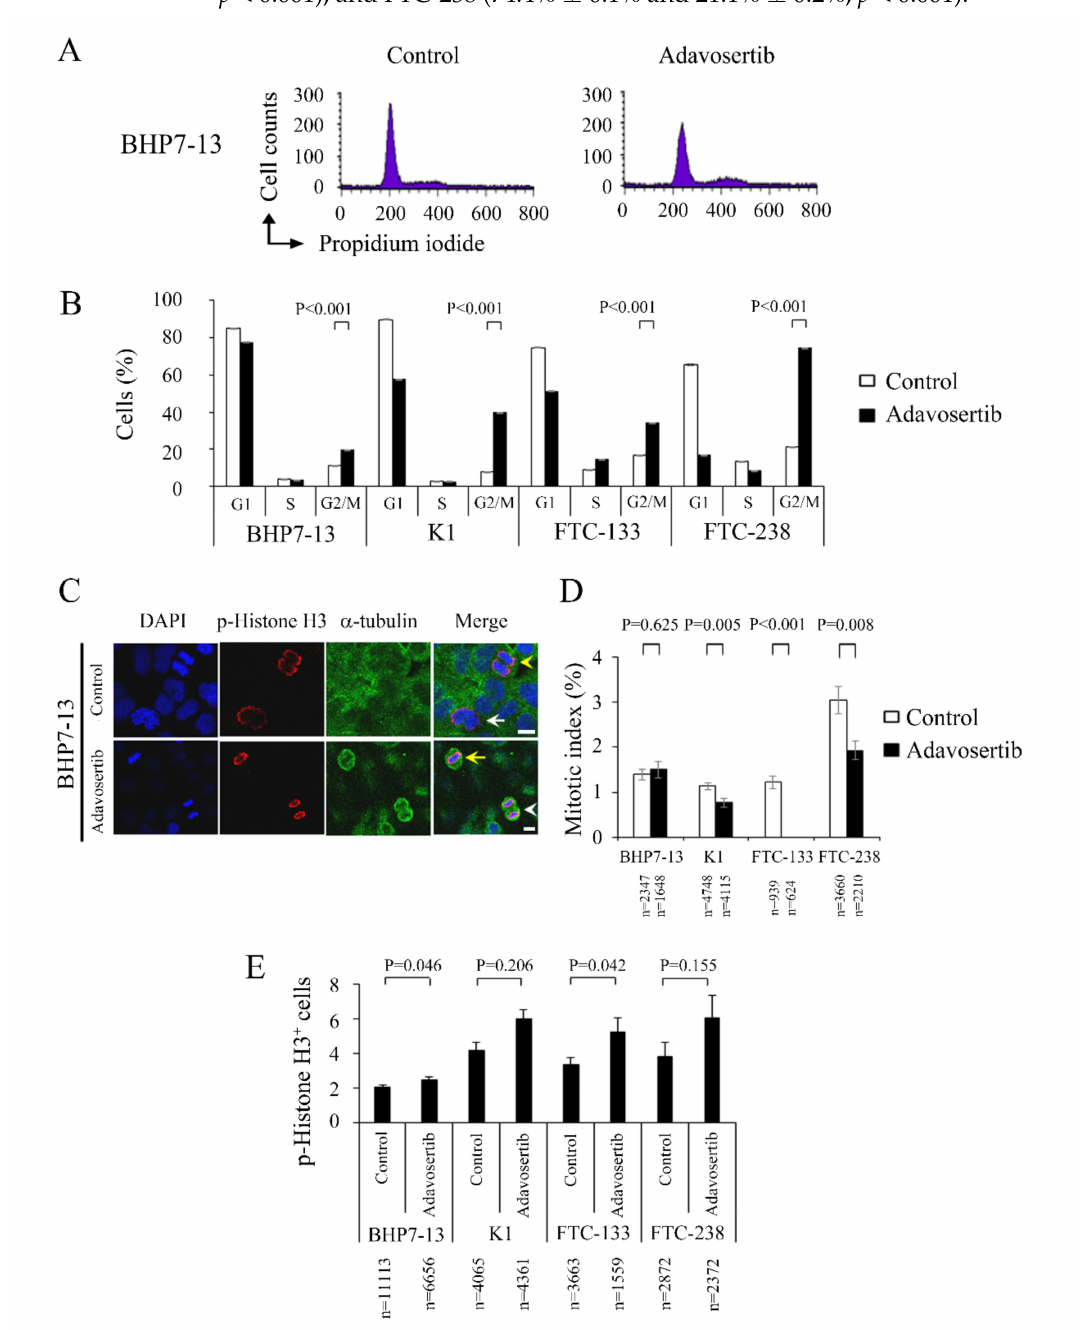
Figure 2. Adavosertib inhibits cell cycle progression in the G2/M phase in four DTC cell lines. ( A ) Cell cycle analysis measuring the DNA content of 1 × 10 4 events using flow cytometry was performed in BHP7-13 cells treated with placebo or adavosertib (500 nmol/L) for 48 h. ( B ) Cell cycle analysis by measuring propidium iodide staining in DTC cells treated with vehicle or adavosertib (500 nmol/L) revealed that adavosertib accumulated cells in the G2/M phase by 48 h (BHP7-13, K1, FTC-133) and 24 h (FTC-238). ( C ) BHP7-13 cells were treated with adavosertib (500 nmol/L) or vehicle for 48 h and stained with fluorescent antibodies targeting DAPI (blue), p-Histone H3 (Ser10) (red) and α -tubulin (green). We